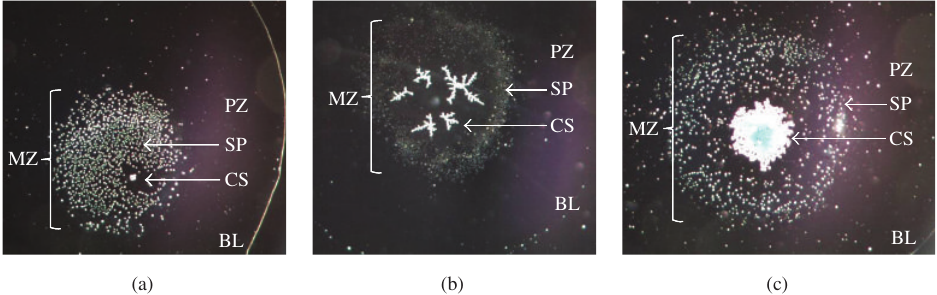
FIGURE 3: Imagines of whole droplet deposits (magnification 25X) describing crystalline structure (CS), single spot (SP), middle zone (MZ), peripheral zone (PZ), and border line (BL). Different CS shapes sur- rounded by several SPs are reported: (a) nonramified small CS; (b) few simple ramified and noncentered CSs; (c) complex and centered